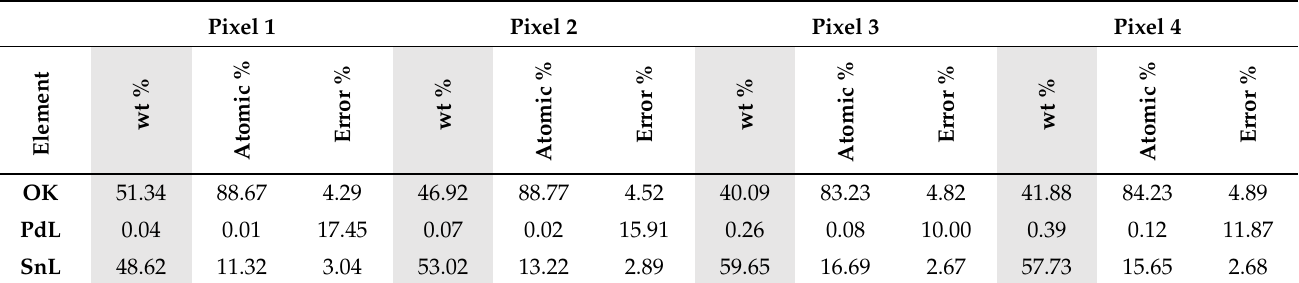
Table 2. EDX analysis using the standardless ZAF quantification method of Pd, Sn and O elements in the transferred pixels 1–4.